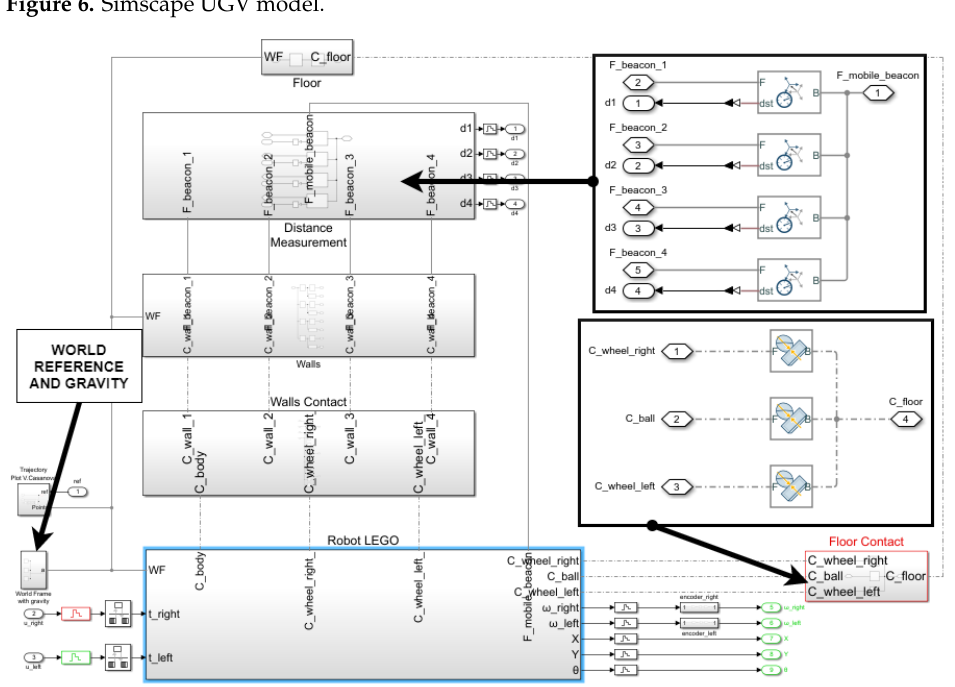
Figure 7. Simscape wheels-on-the-ground simulation model and